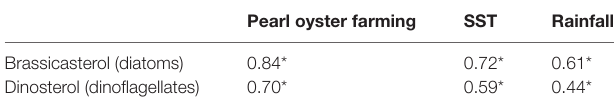
TABLE 1 | Pearson correlation coefficients. Pearl oyster farming SST Rainfall Brassicasterol